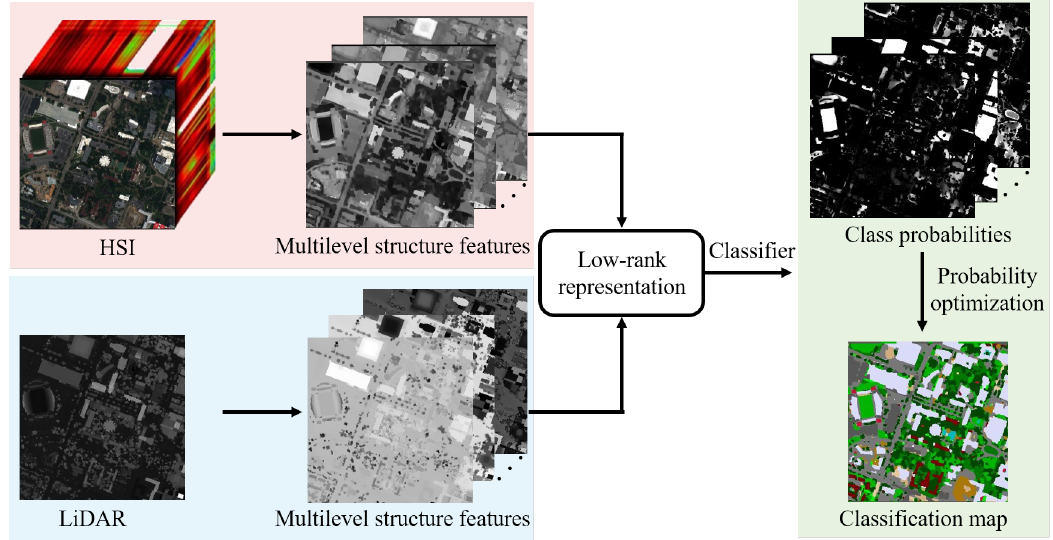
Figure 1. The schematic of the proposed multilevel structure extraction